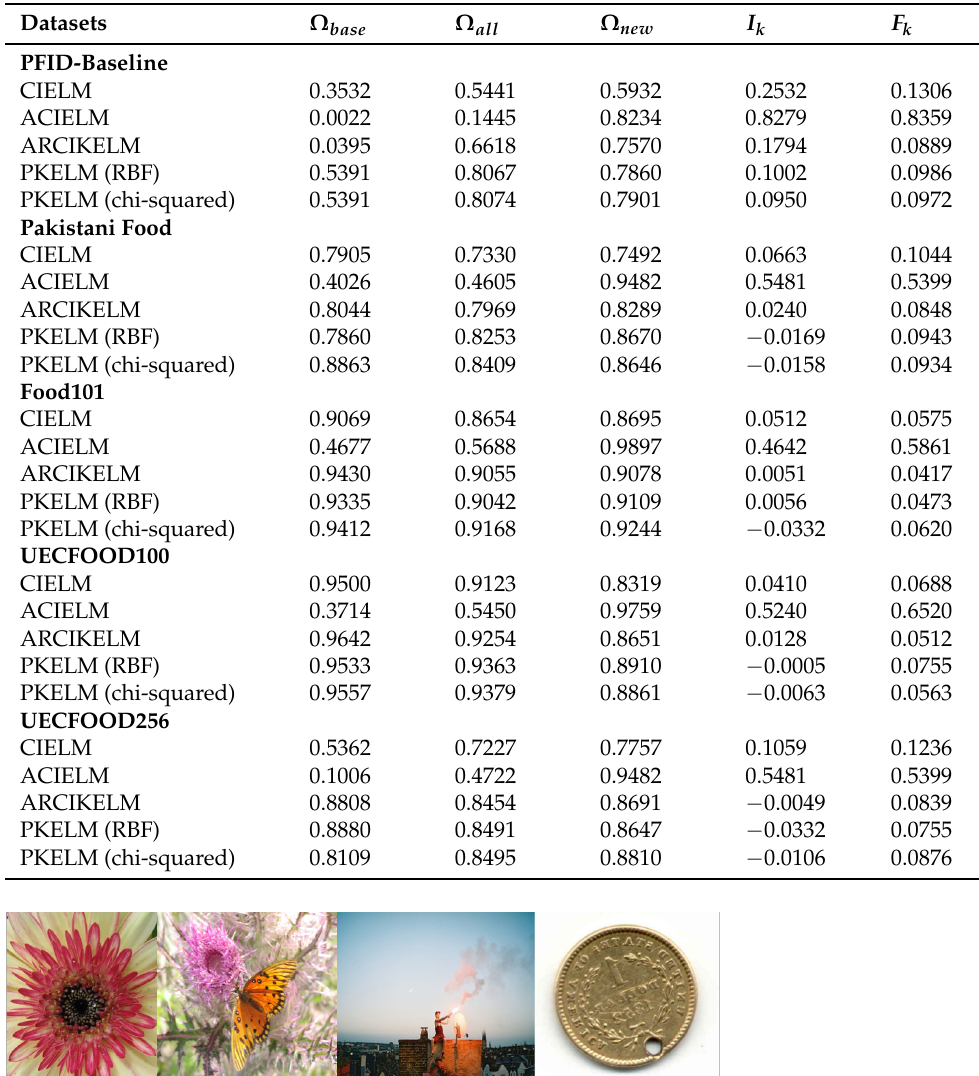
Figure 22. Samples of non-food images used in our experiments.